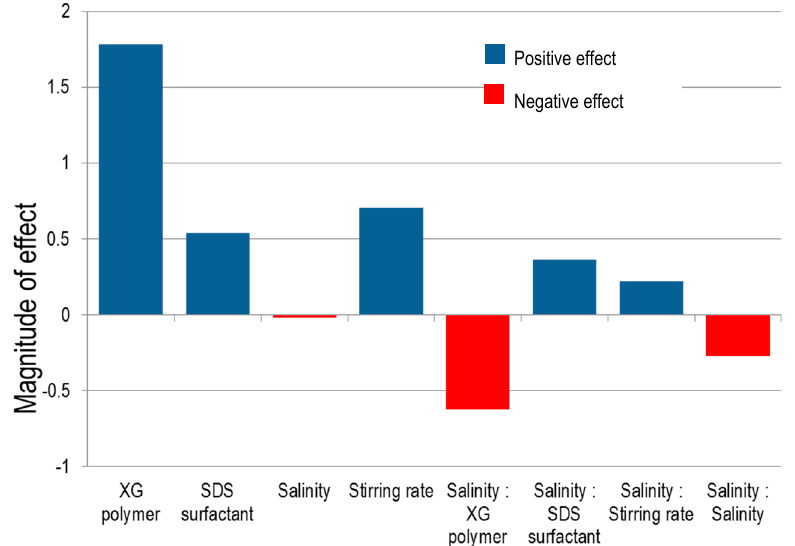
ff ects in regression model Equation Figure 7. Magnitude of effects in regression model Equation (2). Figure 7. Magnitude of e